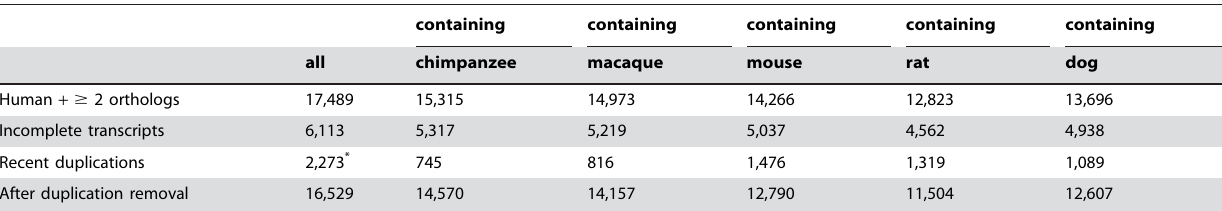
Table 1. Numbers of ortholog sets.